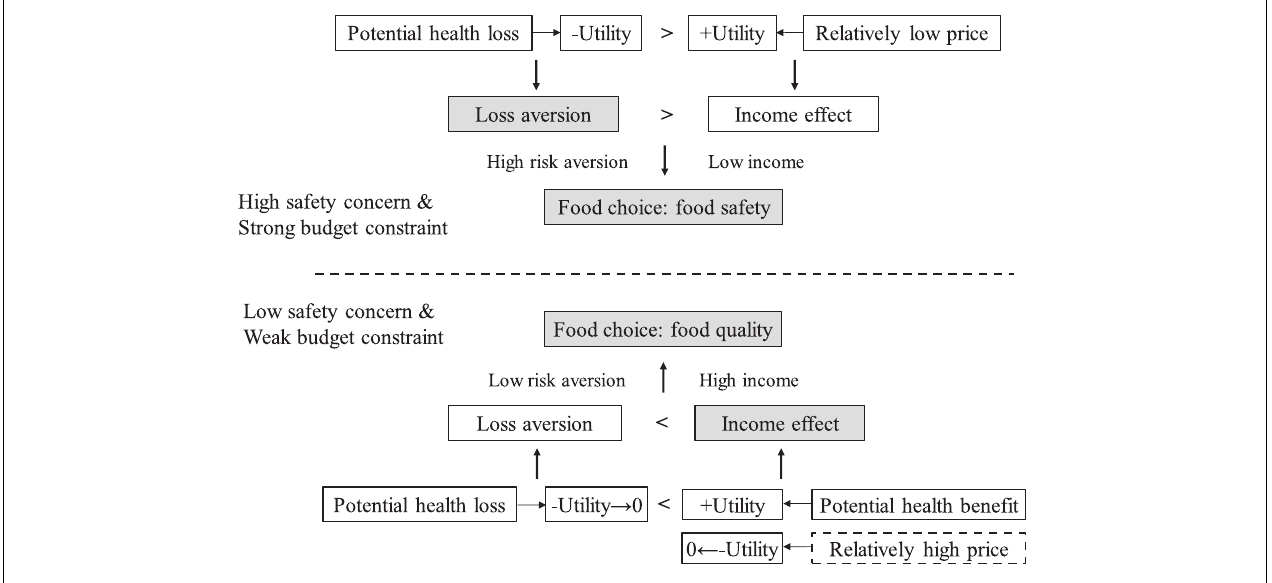
FIGURE 1 | The influence of loss aversion and income effect on consumer food choice.